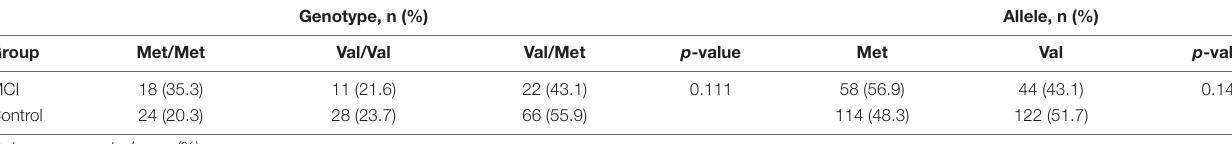
TABLE 5 | Distributions of BDNF genotype and allele frequencies between groups.